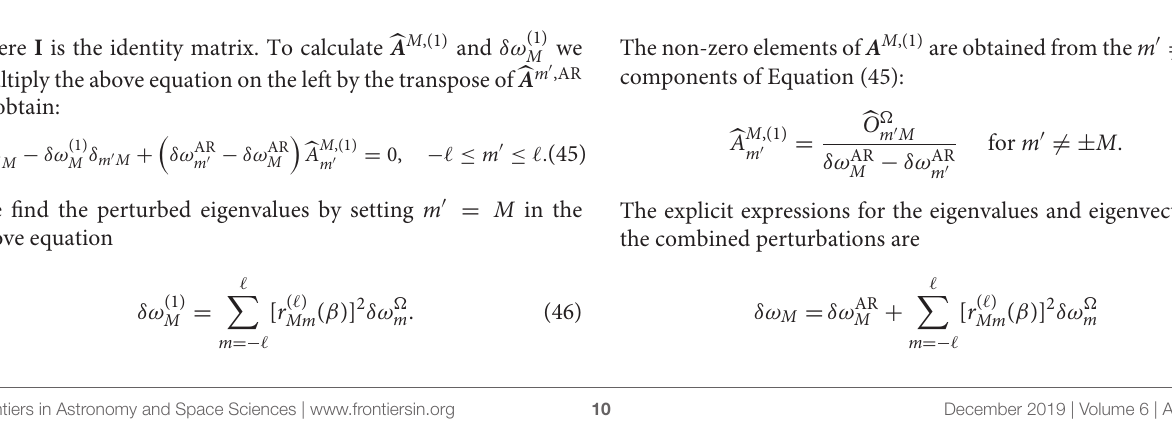
FIGURE 5 | Expectation value of power spectra of oscillation, as functions of inclination angle i . The left panels are for the dipole multiplet ℓ = 1, n = 18, and the right panels for the quadrupole multiplet ℓ = 2, n = 18. The top panels are for the pure-rotation case, the middle panels are for an active region at colatitude β = 20 ◦ , and the bottom panels for β = 80 ◦ . The active region parameters are ε n ℓ = 0.003, α = 23 ◦ , and the stellar rotation period is 8